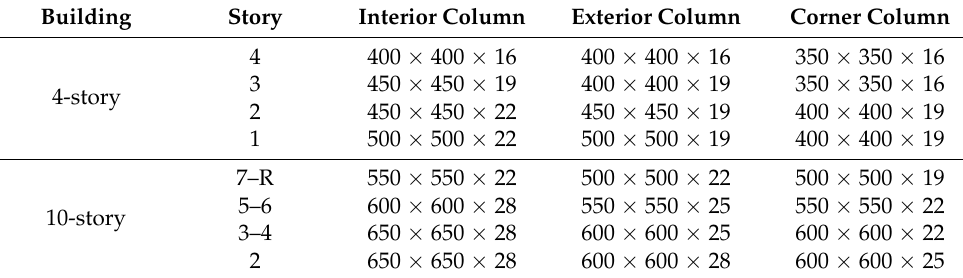
Table 3. Detail and size of structural columns (mm).